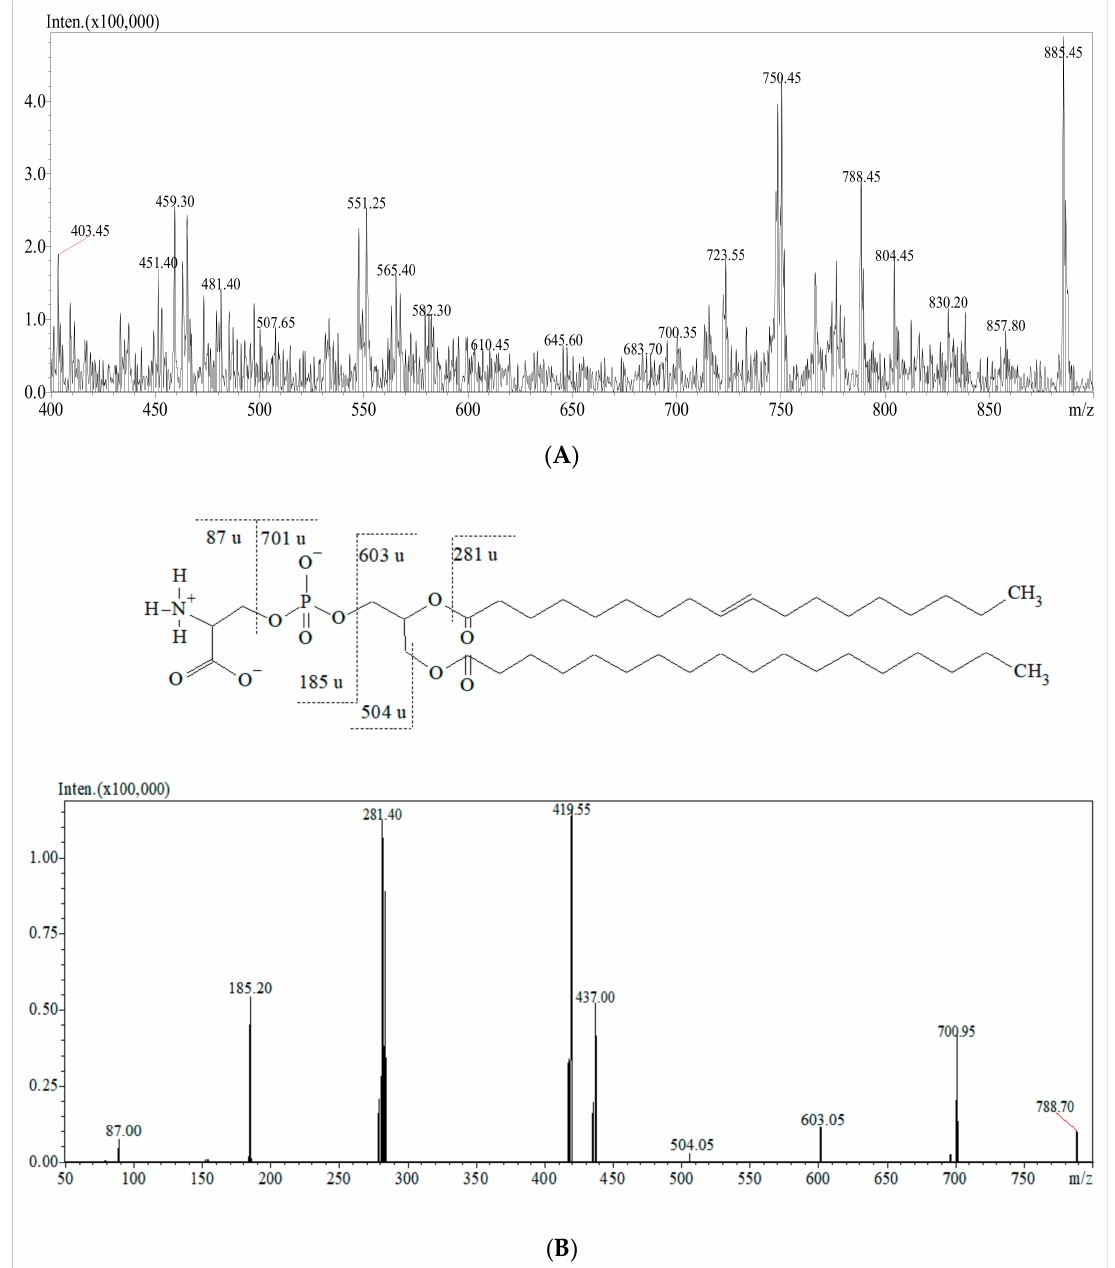
Figure 2. Mass spectra of the lipidomic profile obtained from ESI-QqQ/MS in negative ion mode ( A ) and MS/MS spectra and fragmentation pathway of PS m / z 788.70 ( B